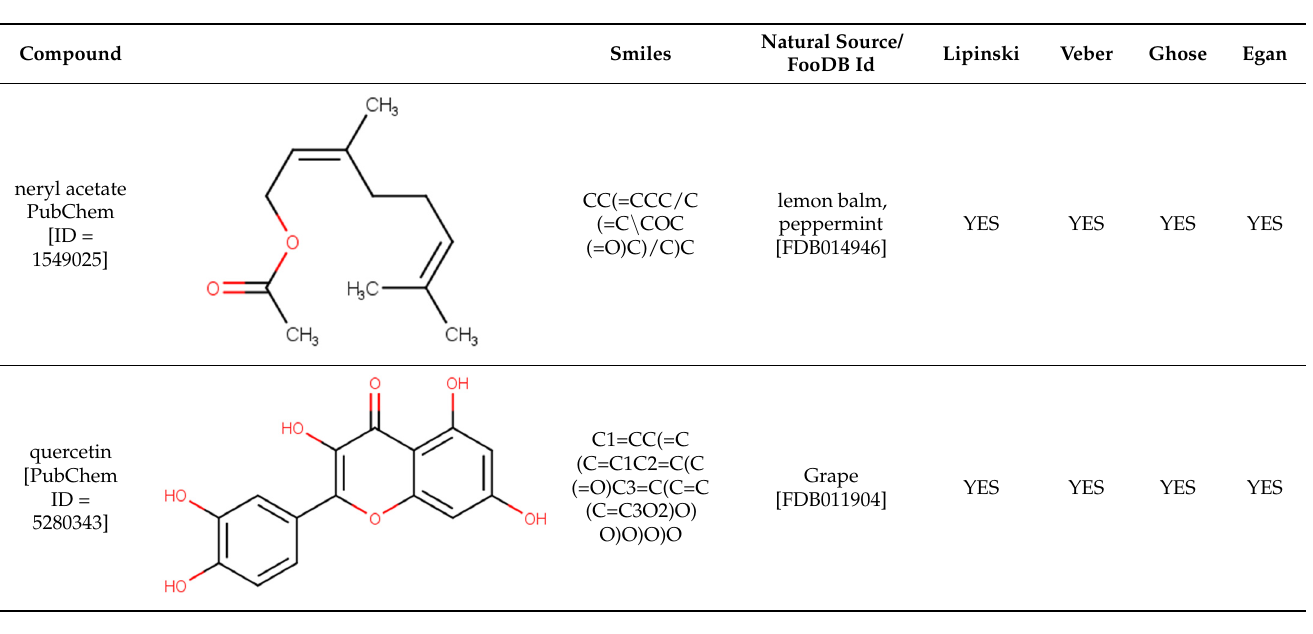
Table 3. Computed human intestinal absorption (HIA), blood-brain barrier permeability (log BBB), CNS permeability, human fraction unbound (HFU), maximum tolerated dose (human), and LD50 for selected compounds.